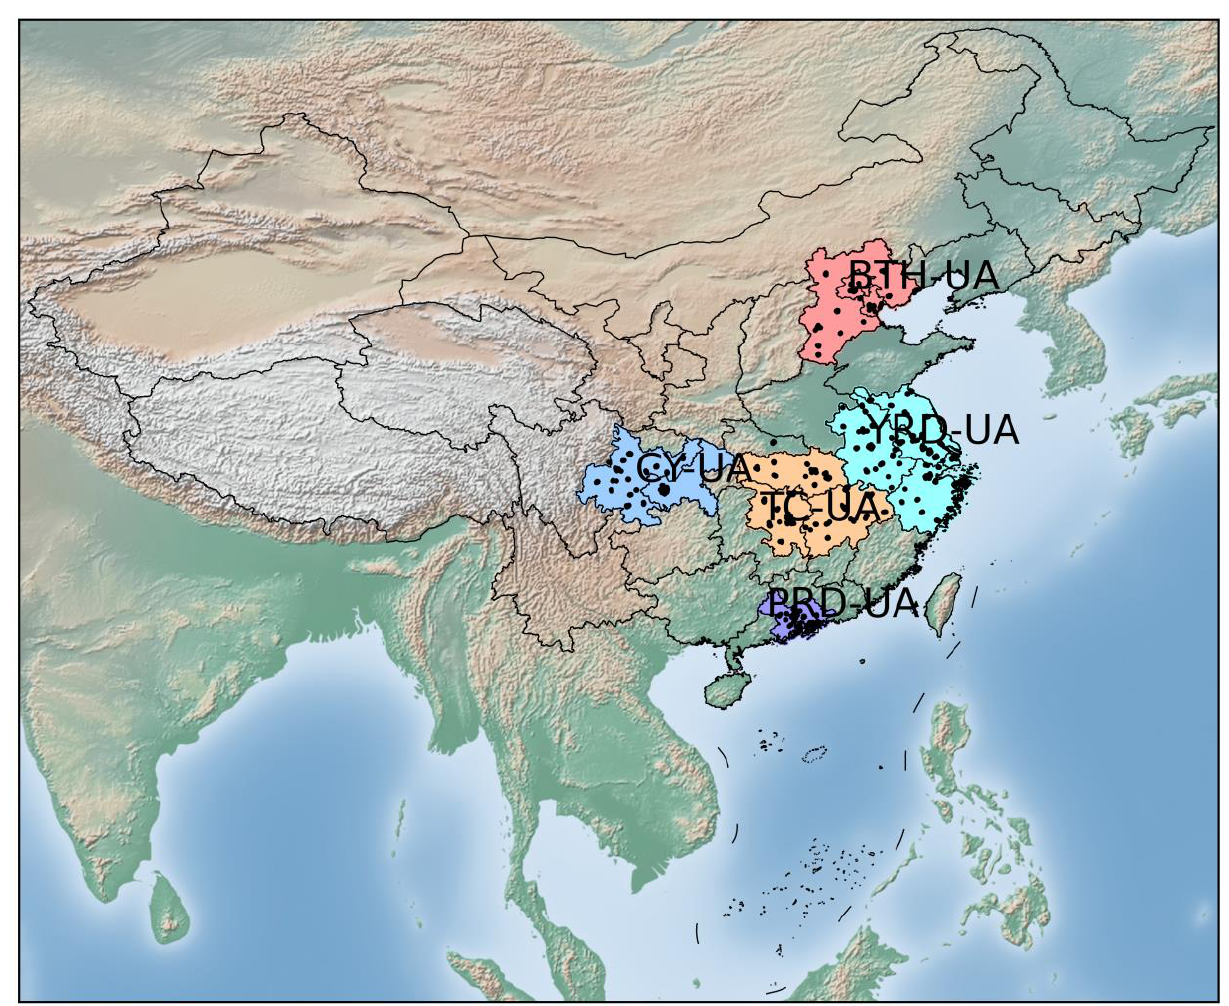
Figure 1. The five major urban agglomerations in China: Beijing–Tianjin–Hebei (BTH-UA), Yangtze River Delta (YRD-UA), Triangle of Central China (TC-UA), Chengdu–Chongqing (CY-UA), and Pearl River Delta (PRD-UA). The black dots represent air-quality monitoring stations.